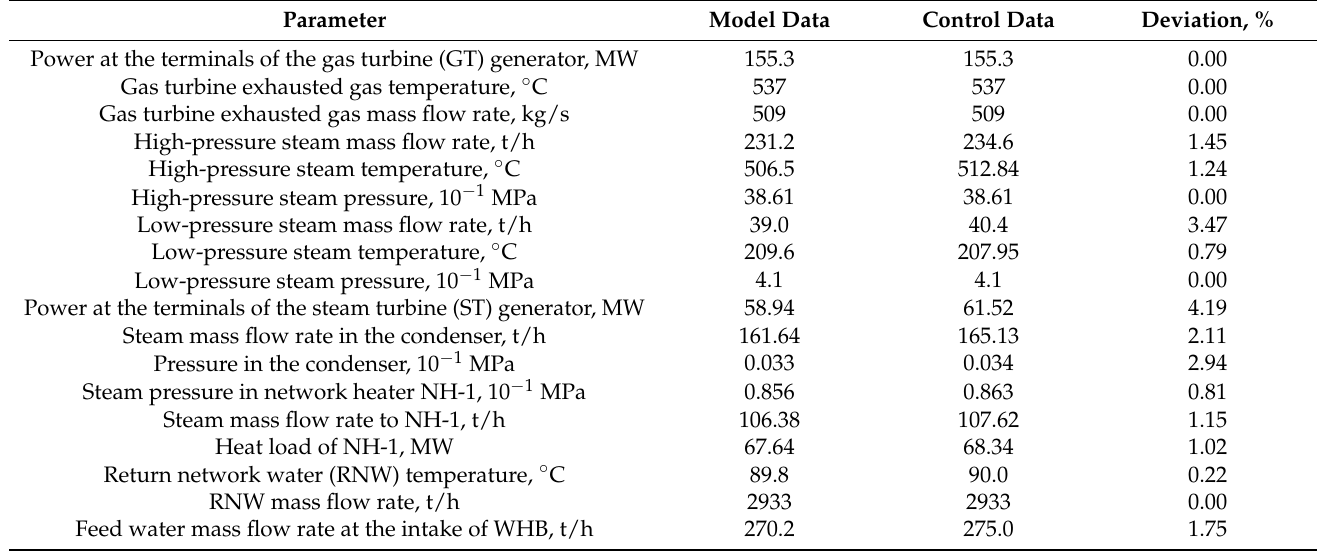
Table 2. Comparison of calculated in United Cycle (UC) and control